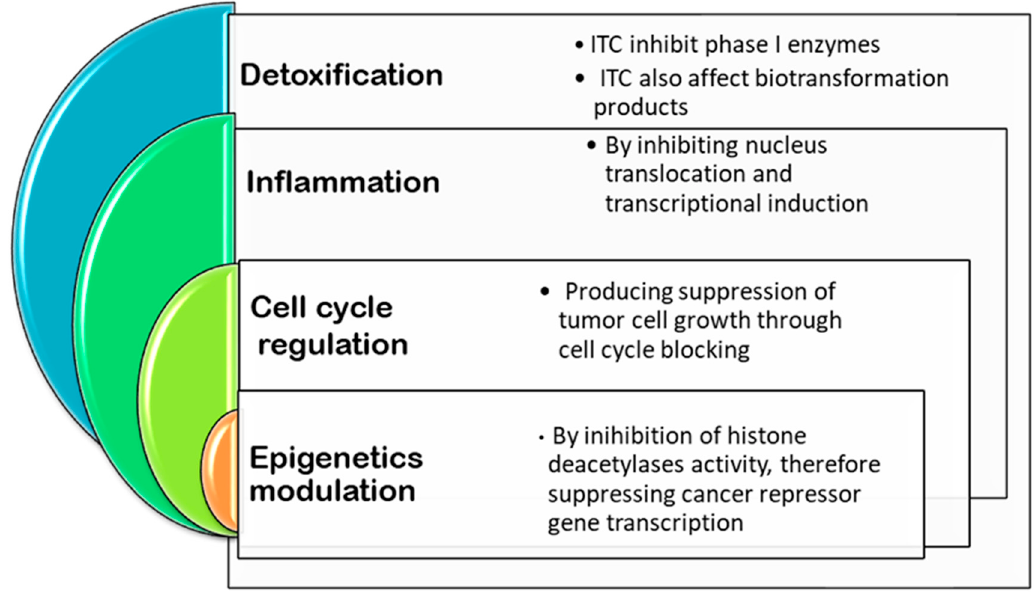
Figure 3. Mechanisms of action and signalling pathways implied for inhibiting carcinogenesis affected by isothiocyanates.